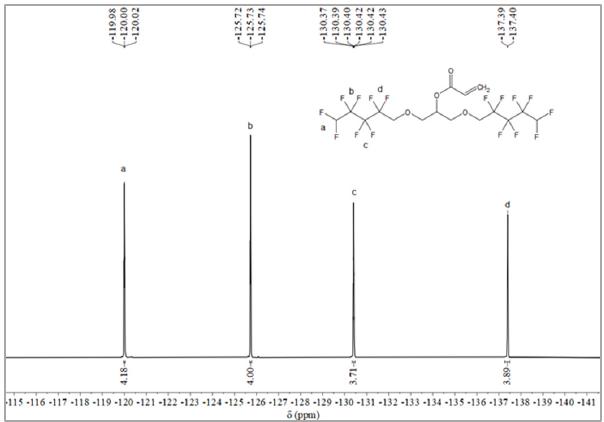
19 F NMR spectra of OFAE. Figure 8.